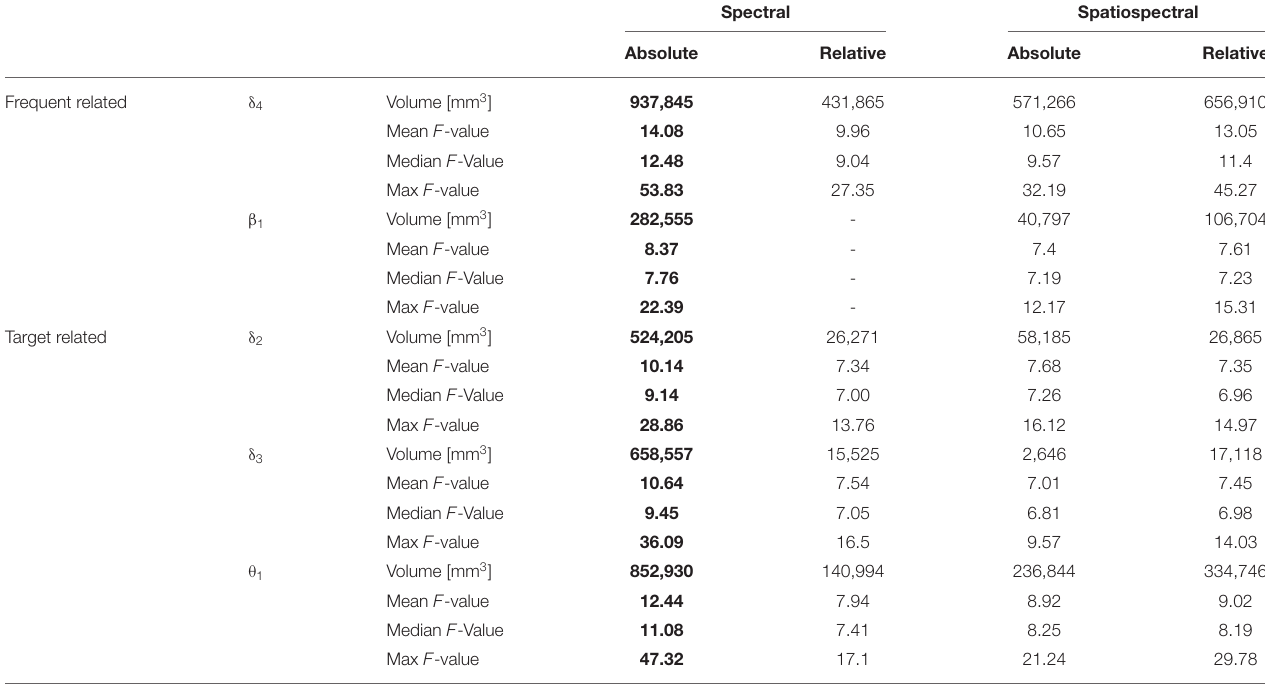
Spectral Spatiospectral Absolute Relative Absolute Relative